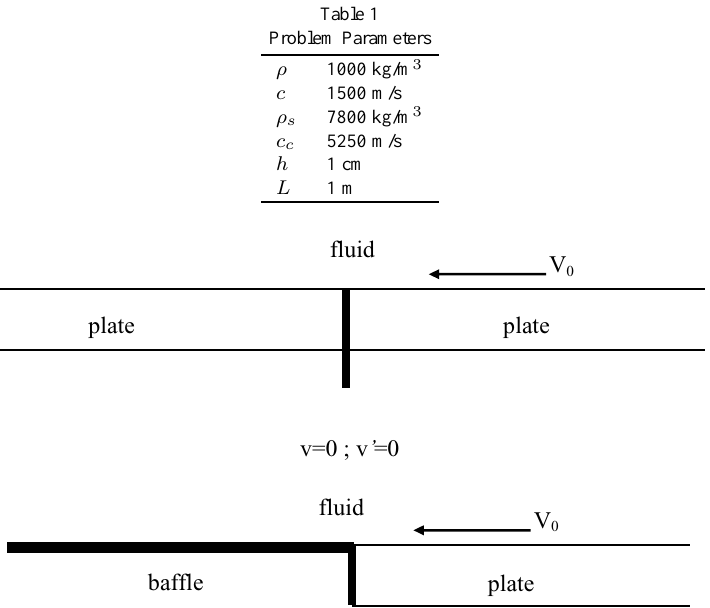
Fig. 1. Infinite plate